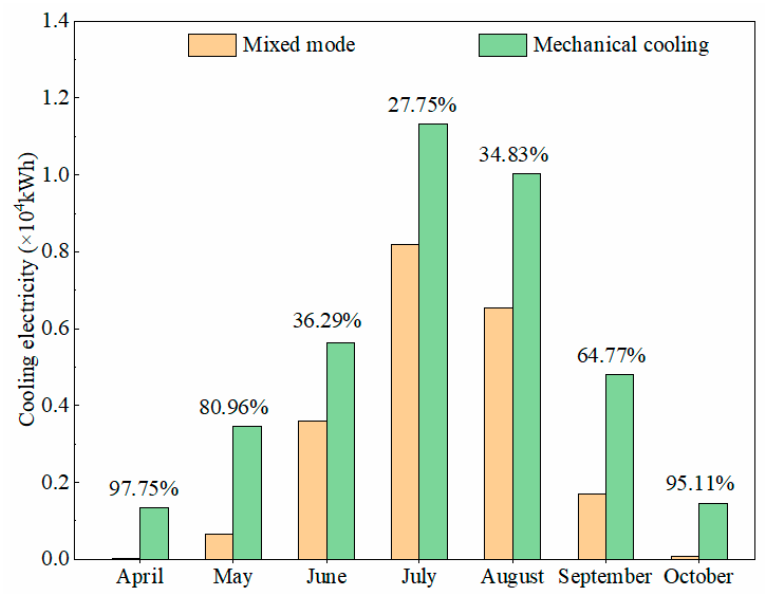
Figure 19. Monthly cooling electricity consumption for mixed cooling and mechanical cooling modes.